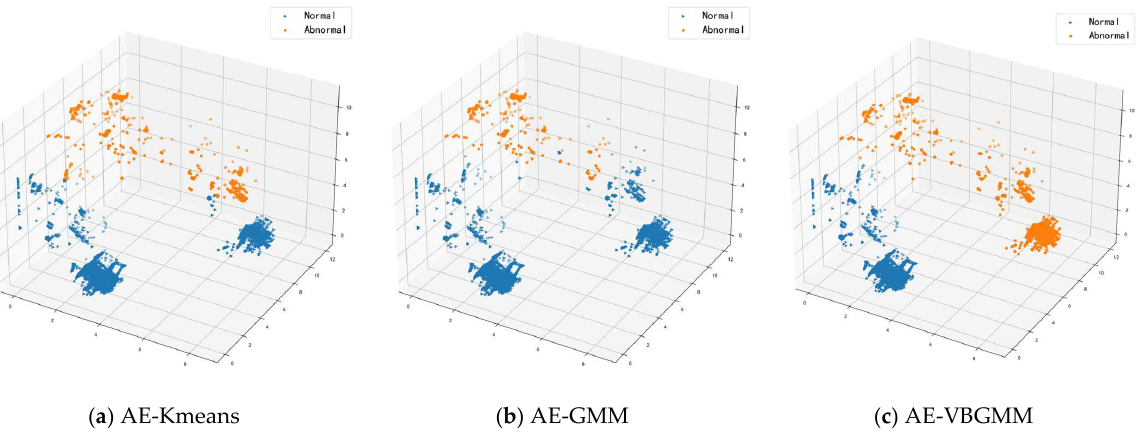
Figure 7. Anomaly detection of normal data benign and abnormal data udpflooding by AE-Kmeans,